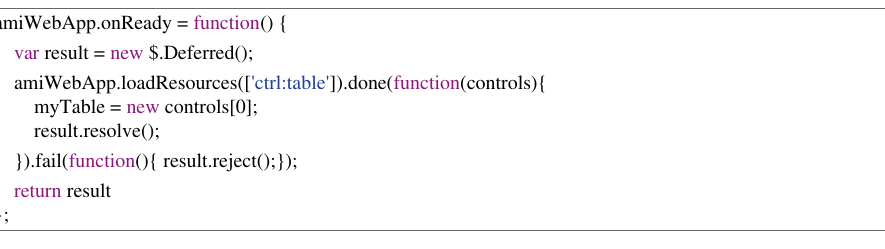
Fig. 5. Loading AWF “table” graphical control.